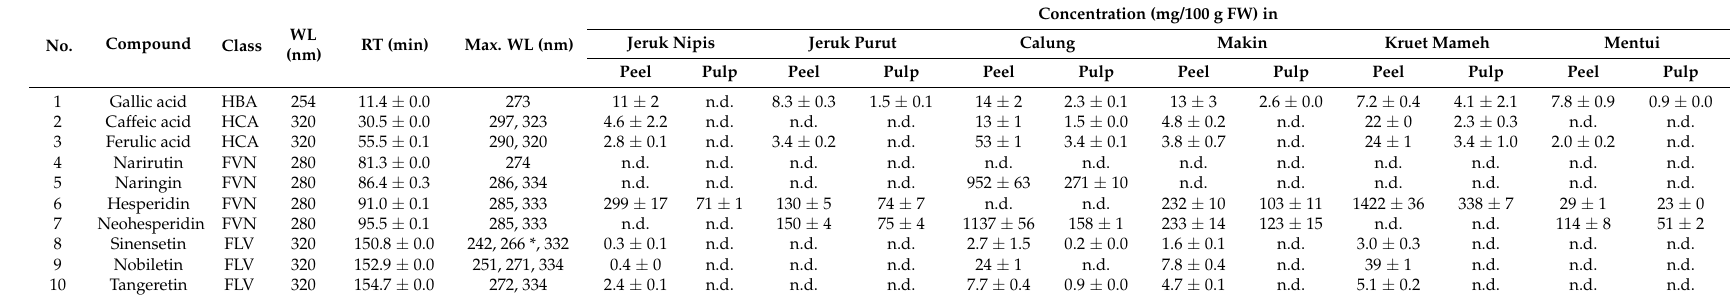
Table 1. Polyphenols in peel and pulp of citrus samples from Aceh. Results are expressed as mean ± SD ( n =